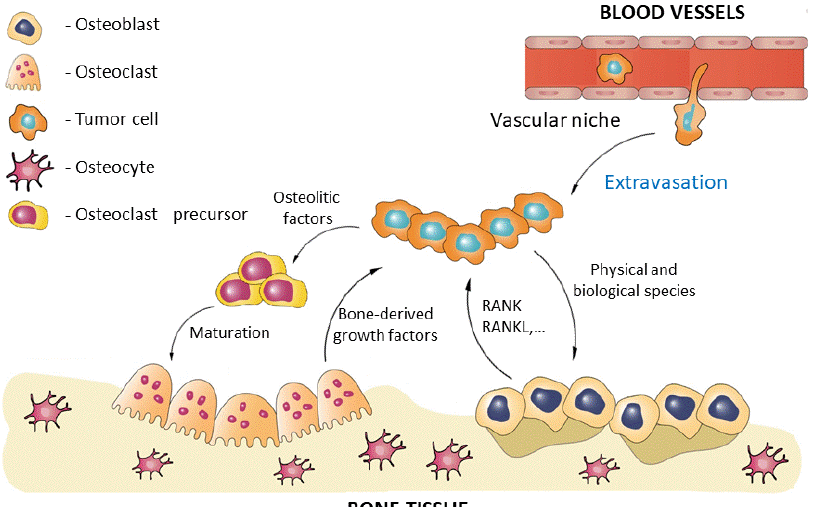
Figure 2. Schematic representation of the cancer cells interactions in bone, including osteoblasts, osteoclasts, and osteoclasts precursors, after activation of the vascular niche. Hematopoietic stem cell (HSC) niche for bone metastasis considers the microenvi- ronment where HSCs are thought to reside in the bone marrow, and several cell types, such as vascular endothelium and endosteal osteoblasts [54]. Some studies support the hypothesis that bone metastatic cancer cells disseminate in the same manner as HSCs homing in bone marrow, based on several factors that have been implicated in how tu- mor cells hijack the HSC niche, such as TANK-binding kinase 1-TBK1 (an enzyme with kinase activity, regulates cell proliferation, apoptosis, autophagy, and anti-tumor im- munity) and Growth arrest-specific 6-GAS6 (involved in the stimulation of cell prolifera- tion) [55]. Additionally, the bone morphogenic proteins (BMPs) derived from HSCs, such as BMP-2 and BMP-6, are involved in osteoblast differentiation and the osteoblasts maintain the endosteal HSC niche; a positive feedback loop between HSCs and osteo- blasts is formed, which leaves an open opportunity for cancer cells to interfere in normal bone formation [56]. Other hypotheses sustain the idea of involving cancer stem cells (CSCs) in bone metastases. Cancer stem cells are cancer cells with tumor-initiating potential, and it is considered to have the capabilities of self-renewal and differentiation [57,58]. In this way, they lead to the development of tumors based on heterogeneous cell populations. As these stem-cell-like properties are required to initiate secondary tumor formation in dis- tant organs, CSCs are expected to play a central role in the development of bone metas- tases. CD44, a representative marker for stem cells of several cancer types, is an adhesion molecule that binds to the extracellular matrix, mainly hyaluronic acid, and has been implicated in cancer cell migration, invasion, and metastasis [59,60]. To conclude, cancer bone metastasis is a very complex process that involves tumor cells, but also different other types of cells from surrounding tissue and entire body, and cells which are evolved in the metastatic tissue. Some molecular markers can be identi- fied in the early stages of metastasis and used for diagnostic or predictions of evolutions in the case of grade II or III of cancer.